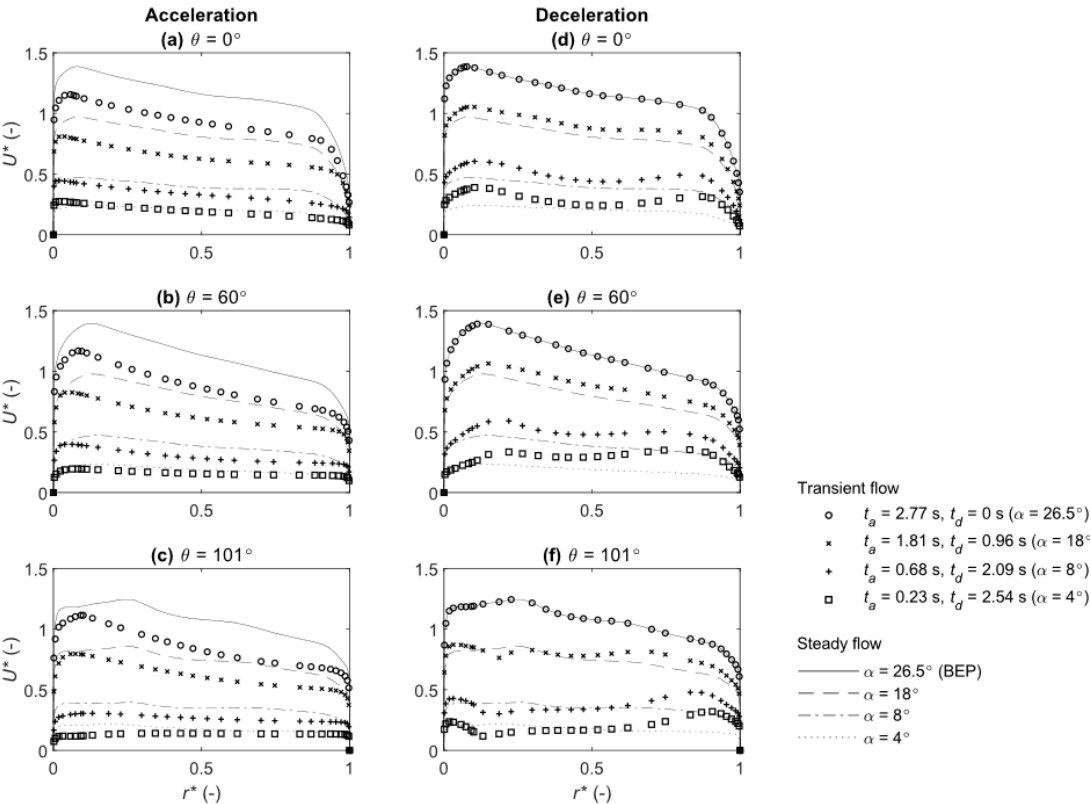
Figure 14. Development of the streamwise velocity ( U ∗ ) during an acceleration (a–c) and deceleration (d–f) along the radial distance r* , given by r ∗ = ( r − r i ) / ( r o − r i ) , where, r i and r o are the radial distance of the inner pressure point ( P 2d ) and outer pressure point ( P od ). The results are plotted at three azimuthal locations of the SC for four di ff erent GVAs (including best e ffi ciency point (BEP)) during the transients and in steady conditions.